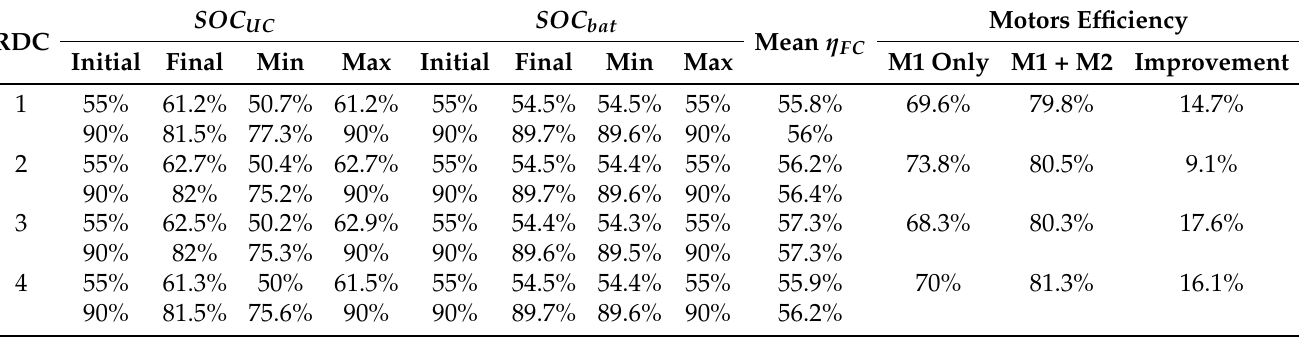
Table 9. Model results without prediction